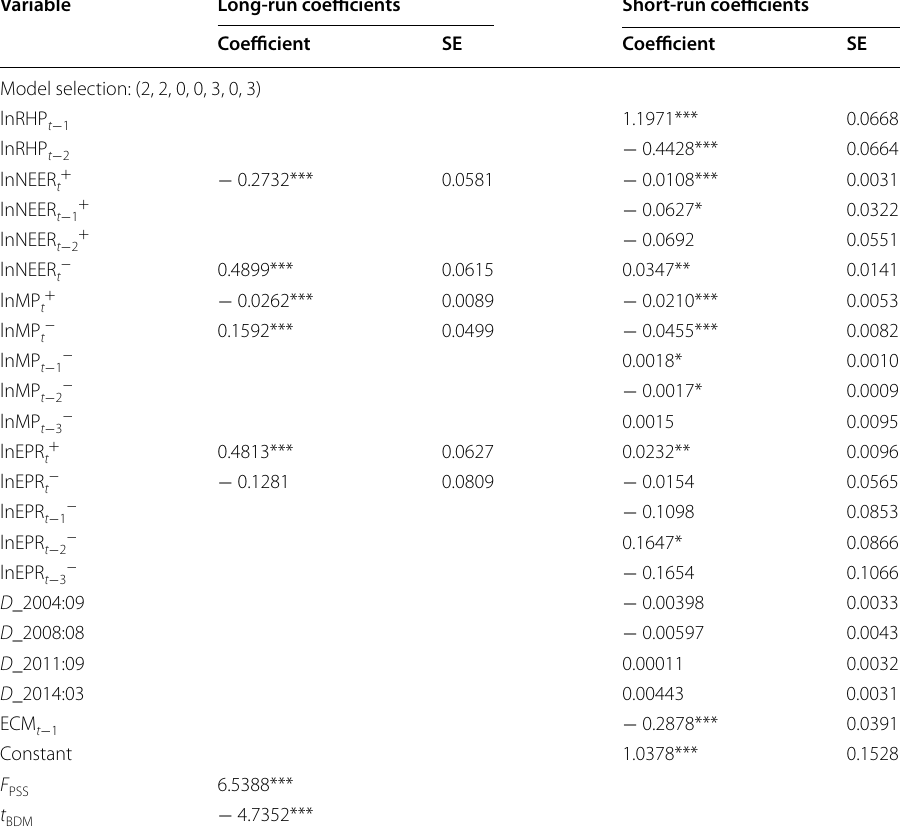
Superscripts *, **, and *** represent level of significance at 1%, 5%, and 10%. F PSS uses F‑statistic and t BDM uses t‑statistic